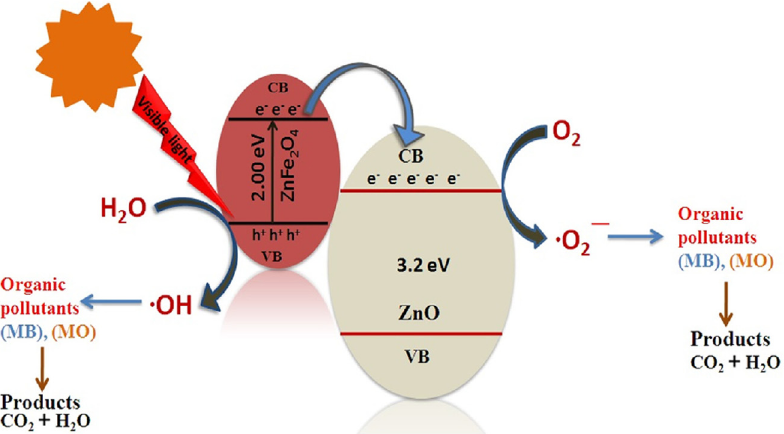
Figure 4. A general scheme of visible light photodegradation mechanism of magnetic nanocomposite i.e., ZnFe 2 O 4 /ZnO for organic pollutants [69]. Republished with permission from